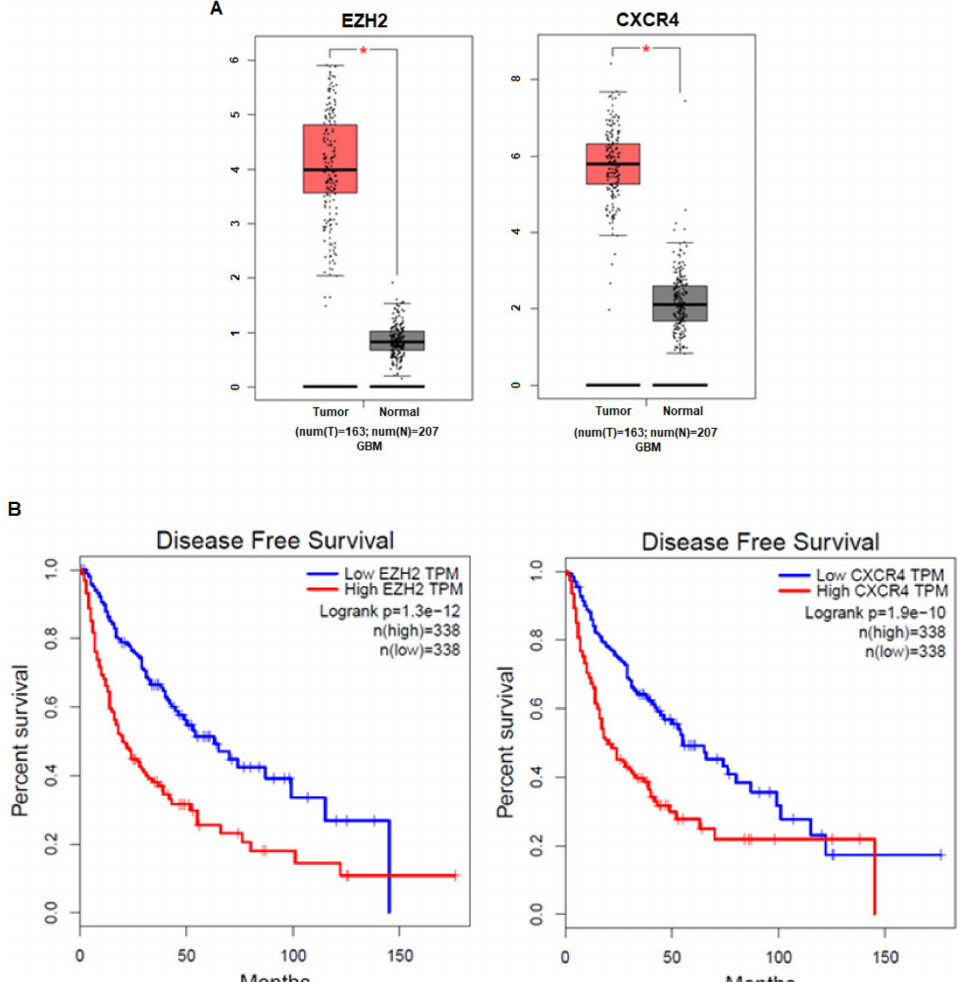
Figure 1. High expression of EZH2 and CXCR4 is associated with the poor prognosis of glioblastoma (GBM) patients. ( A ) EZH2 and CXCR4 mRNA levels are significantly higher in GBM tumor tissues